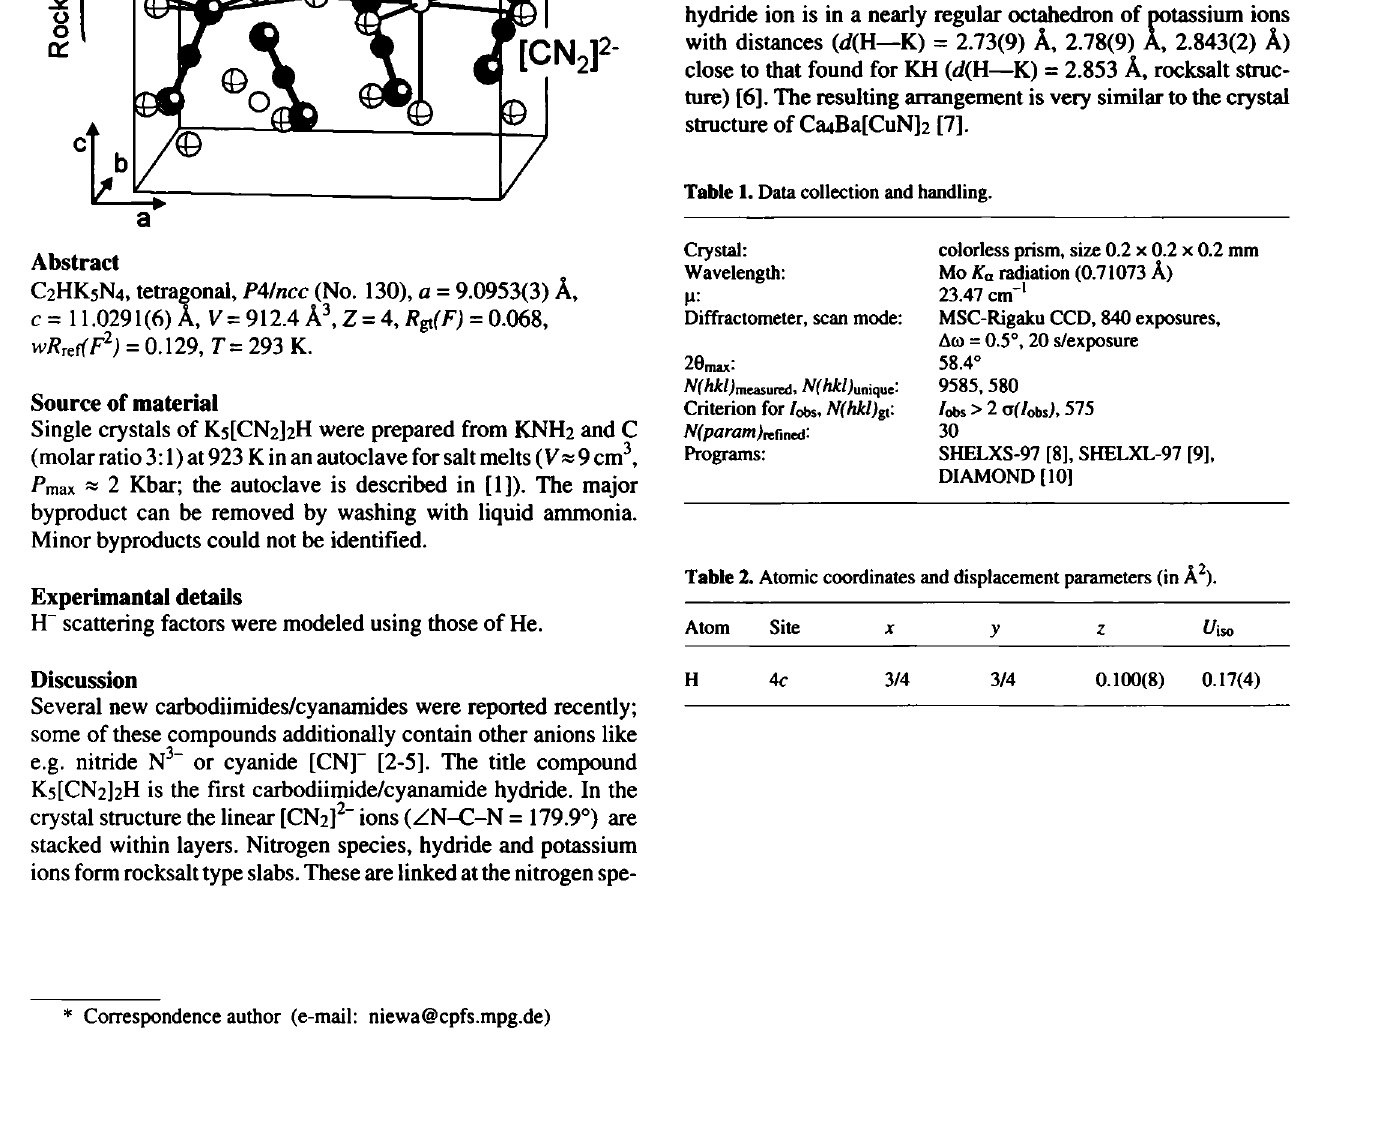
Table 1. Data collection and handling.